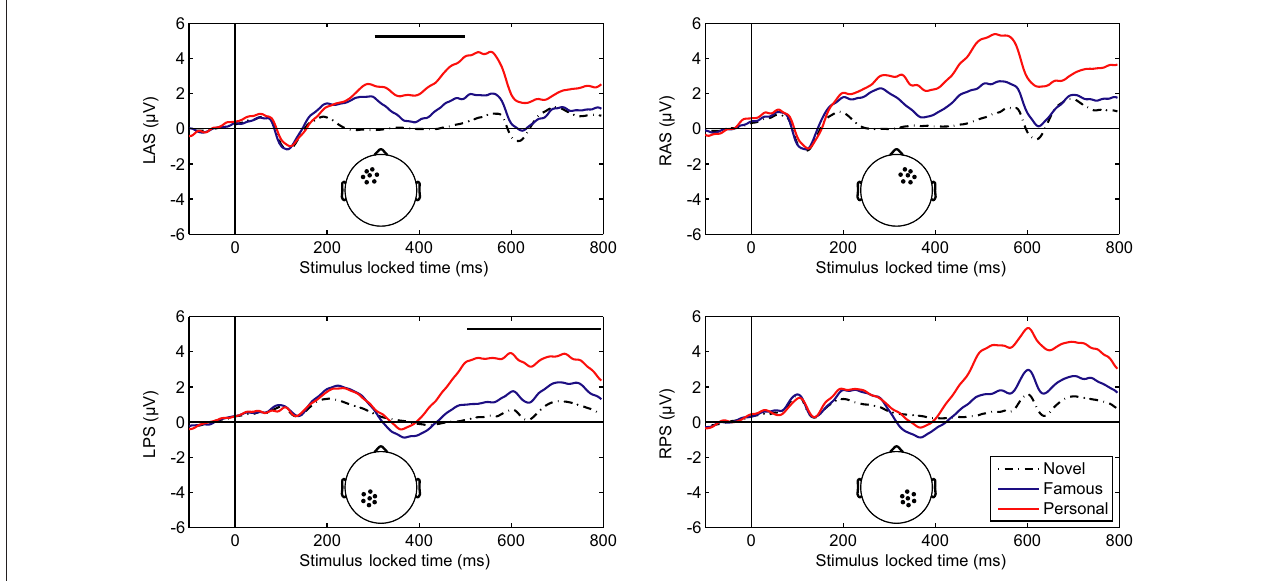
Figure 2 | Averaged-referenced, grand-averaged erPs for depicted channel groups. L, left; R, right; A, anterior; P, posterior; S, superior. Thick overlaid bars in the left column indicate the early (upper) and late (lower) temporal integration